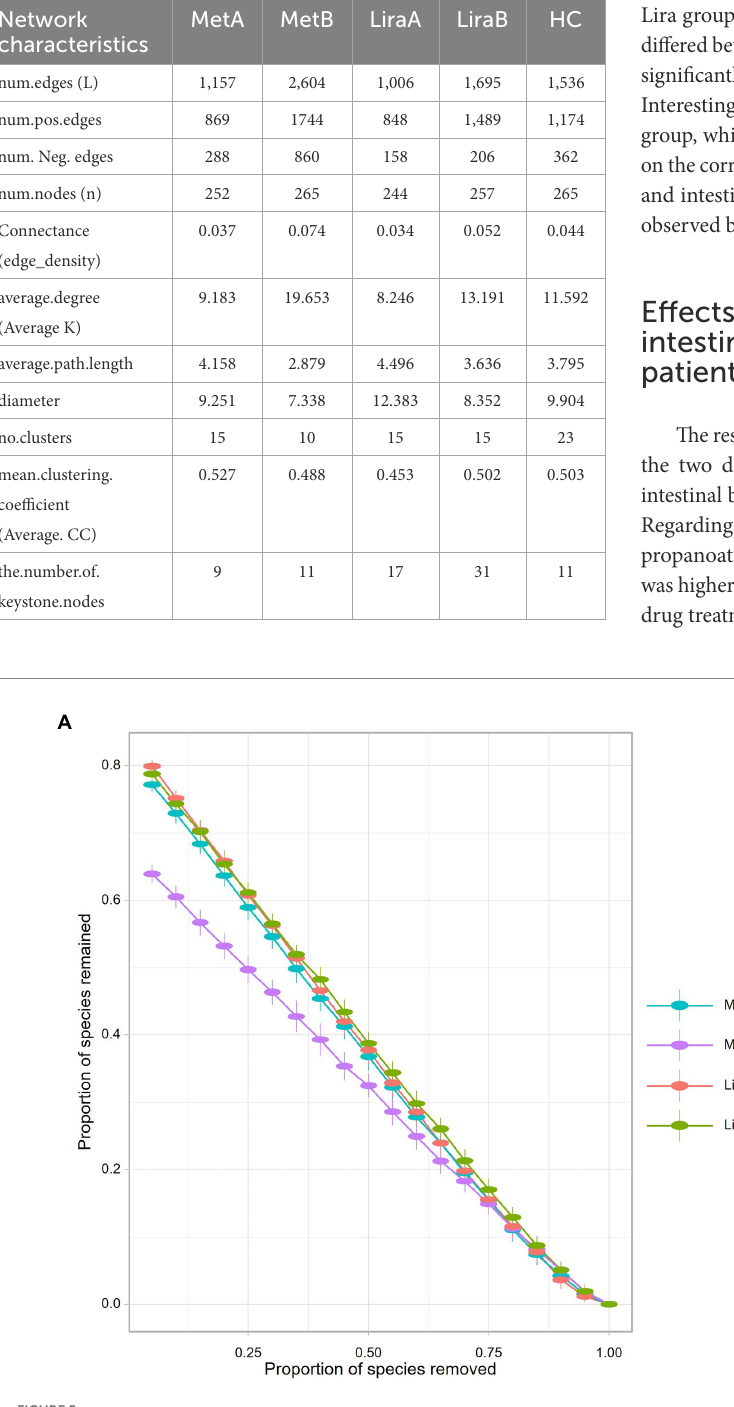
FIGURE 5 (A) Network robustness after exclusion of a proportion of species before and after metformin or liraglutide treatment. (B) Network community stability before and after metformin or liraglutide treatment. (C) Network vulnerability before and after metformin or liraglutide